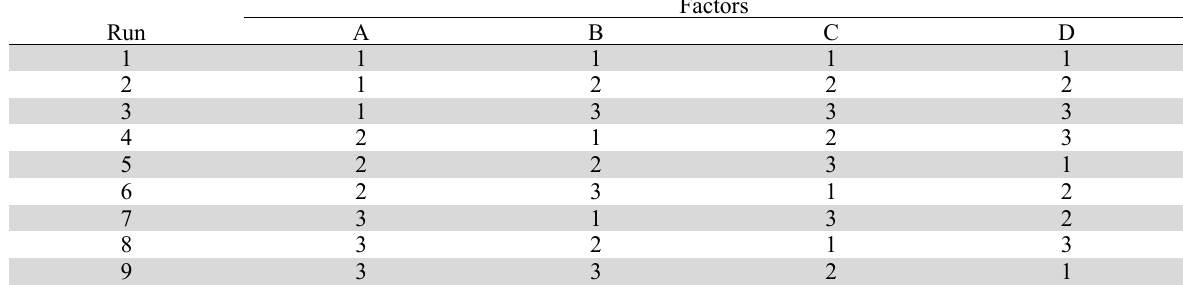
L 9 Orthogonal array